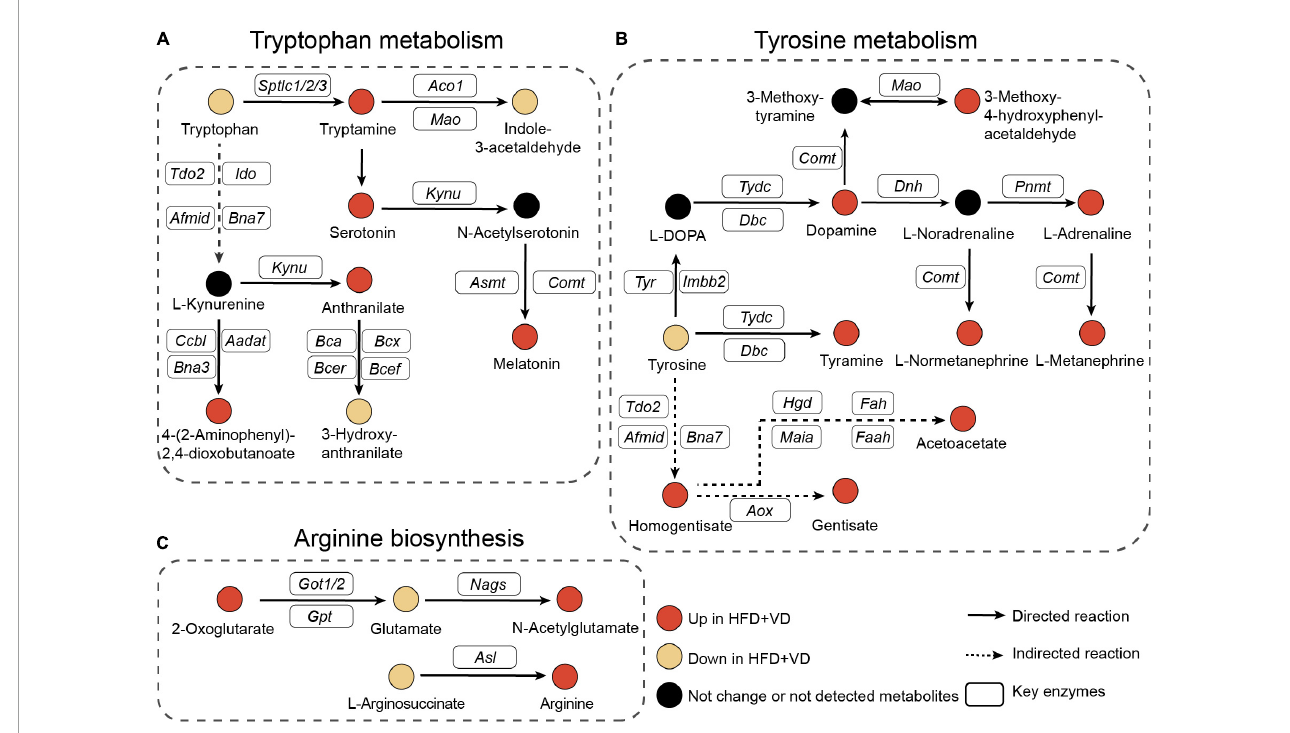
FIGURE6 Pathway’s analysis. (A–C) Illustrative examples of metabolite changes in tryptophan metabolism, tyrosine metabolism, and arginine biosynthesis pathways.